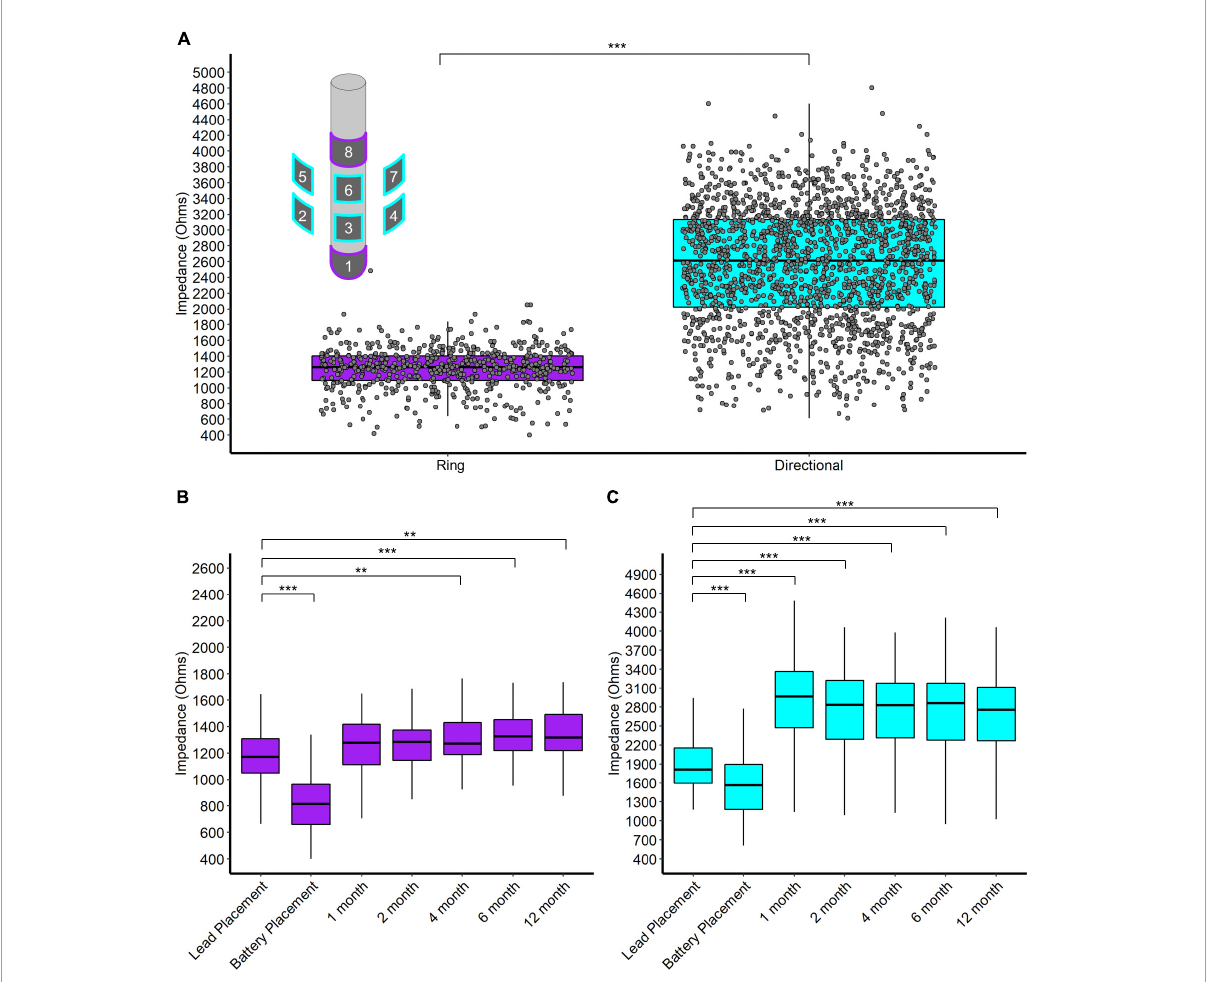
FIGURE3 (A) Scatter and box plot of all monopolar impedance measurements (across patients, contacts, and visits) separated by ring and directional leads. Upper left contains a schema of the directional DBS lead. (B) Box plots of monopolar impedance for ring contacts across visits. (C) Box plots of monopolar impedance for directional contacts across visits. * p < 0 . 05, ** p < 0 . 01, and *** p < 0 .